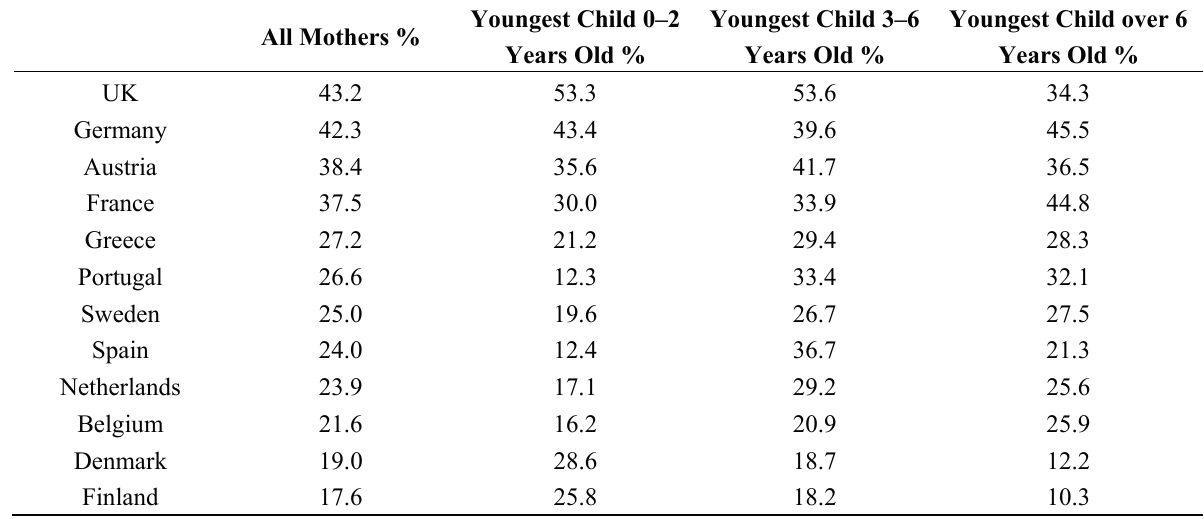
Table 5. Perceived negative career consequences of